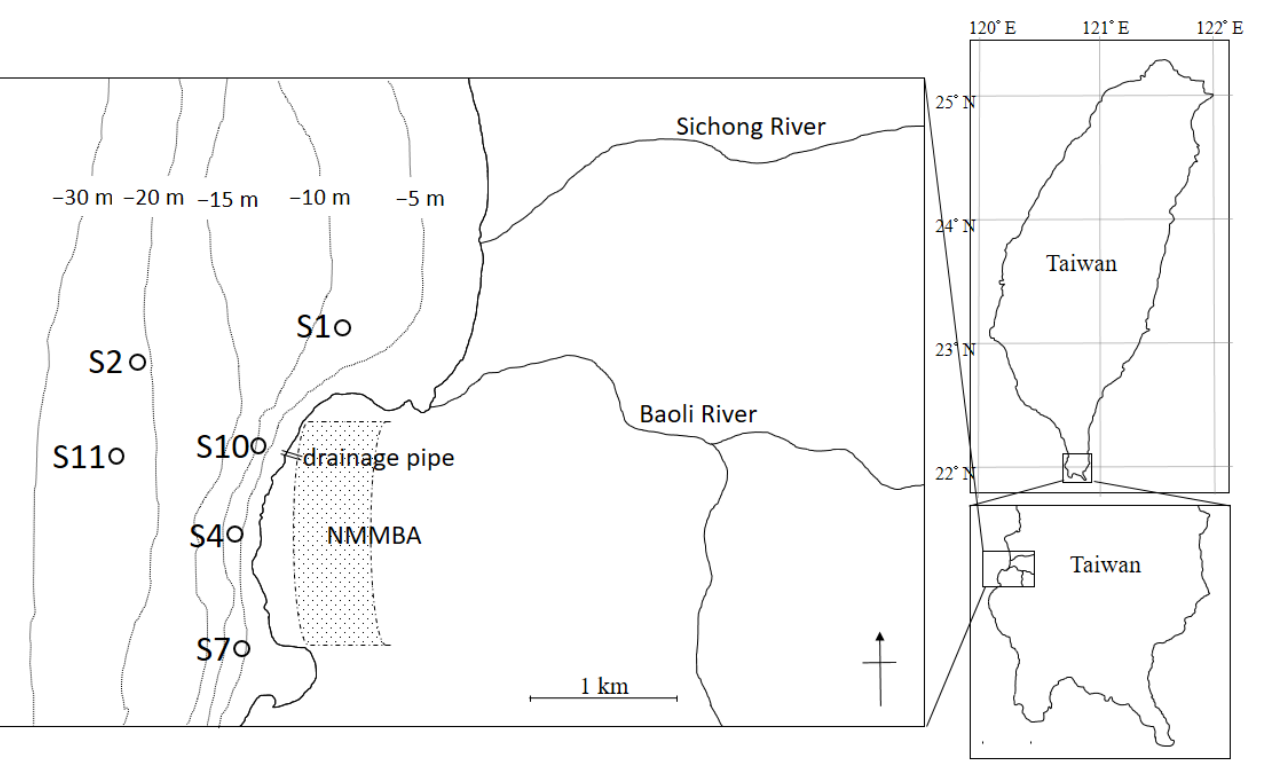
Figure 1. Study area and sampling stations located in southern Taiwan.